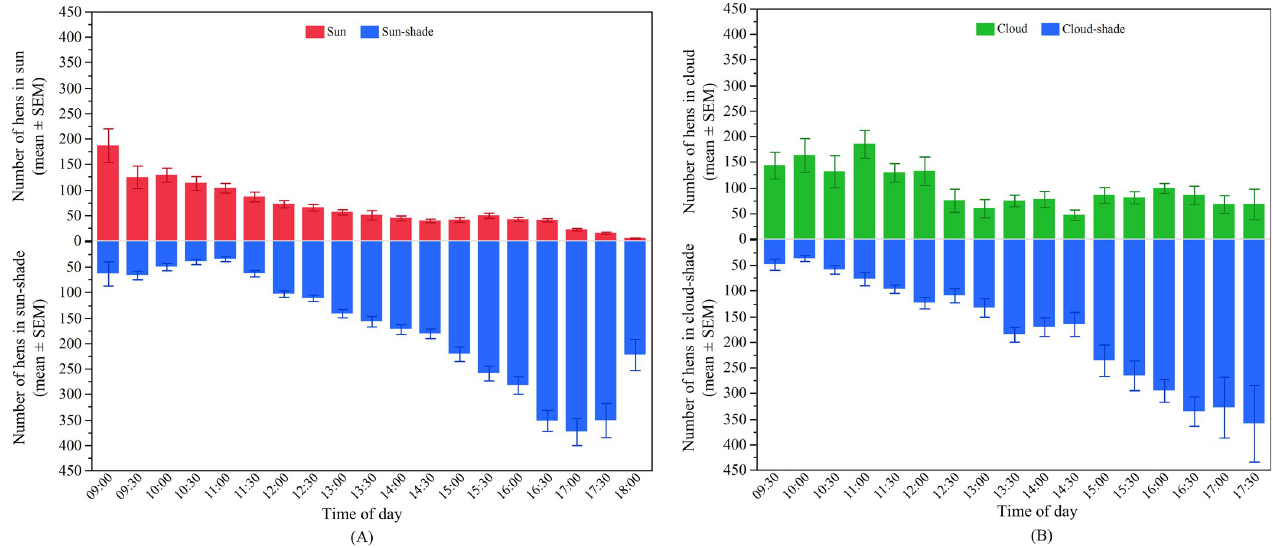
Fig 8. Distribution of hens on the range across the day in WA: (A) The mean ( ± SEM) number of hens in the ‘sun’ (top) and ‘sun-shade’ (bottom); (B) The mean ( ± SEM) number of hens in the ‘cloud’ (top) and ‘cloud-shade’ (bottom).